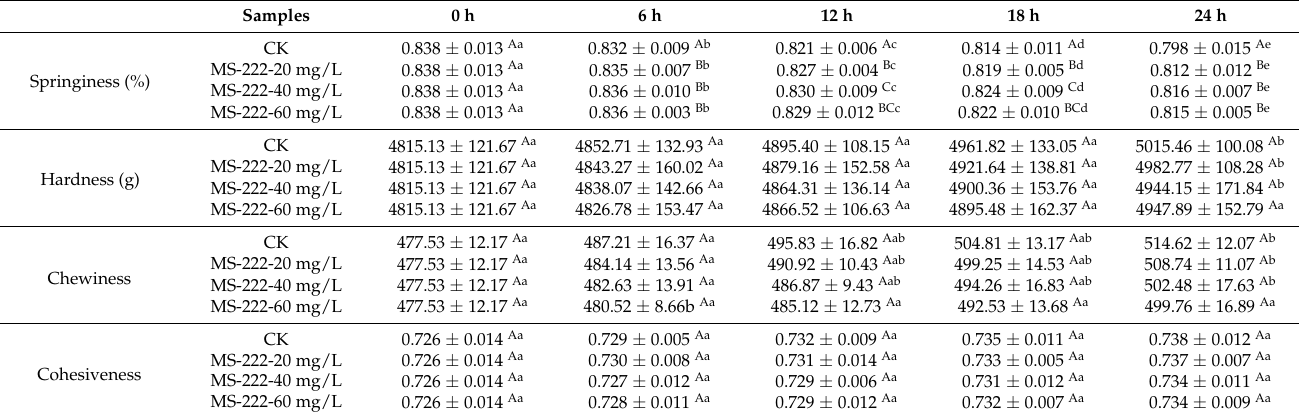
Table 3. Flesh texture of turbot during simulated transport.